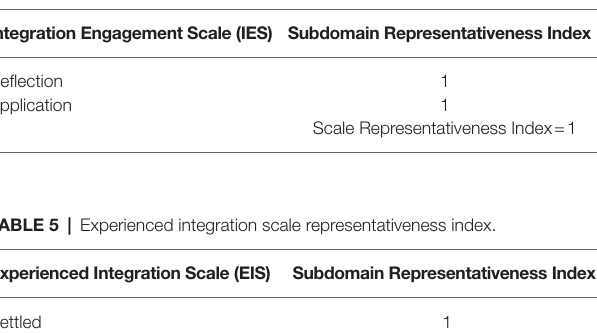
TABLE 4 | Integration engagement scale representativeness index.